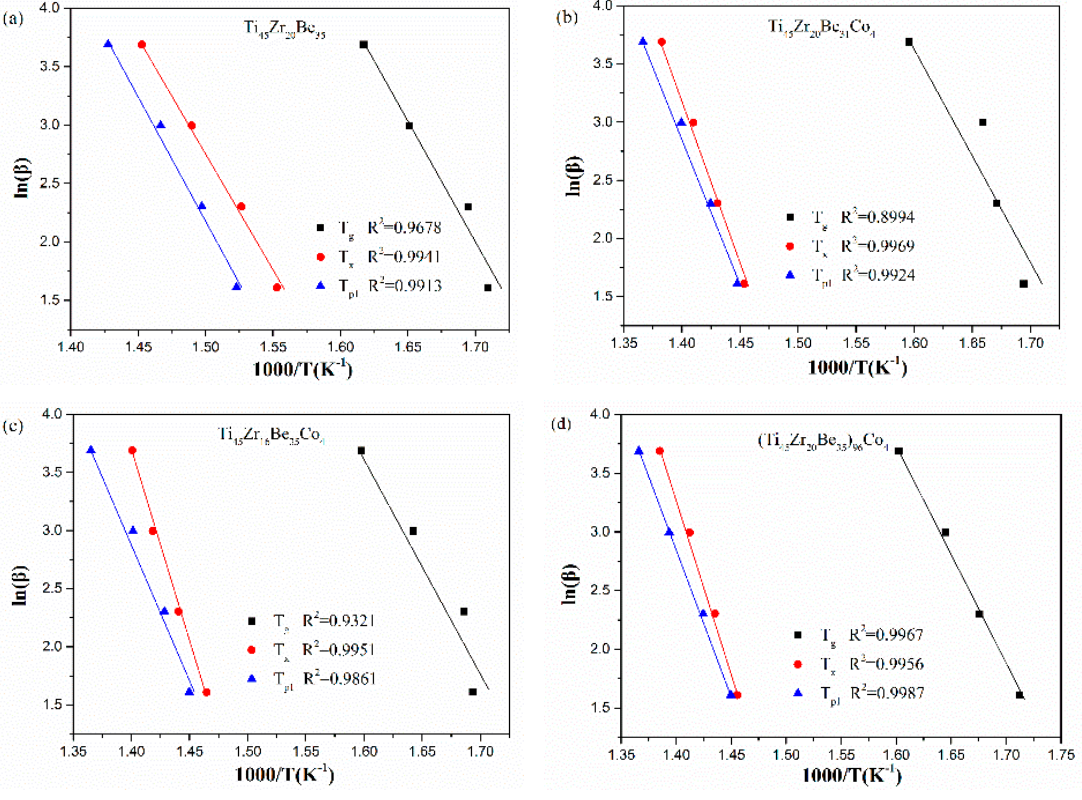
Figure 10. Moynihan (Ozawa) plots for ( a ) Ti 45 Zr 20 Be 35 , ( b ) Ti 45 Zr 20 Be 31 Co 4 , ( c ) Ti 45 Zr 16 Be 35 Co 4 , and ( d ) (Ti 45 Zr 20 Be 35 ) 96 Co 4 BMGs. Table 5. The values of E g and E x calculated by Kissinger and Moynihan equations. Method